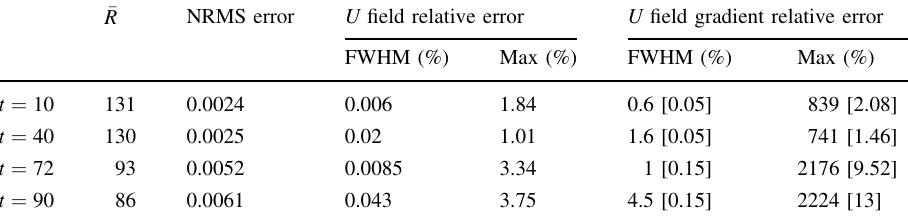
Table 2 Compression ratio R , NRMS error and relative error statistics in the reconstructed velocity magnitude U field and its gradient for different time steps of RCCI simulation